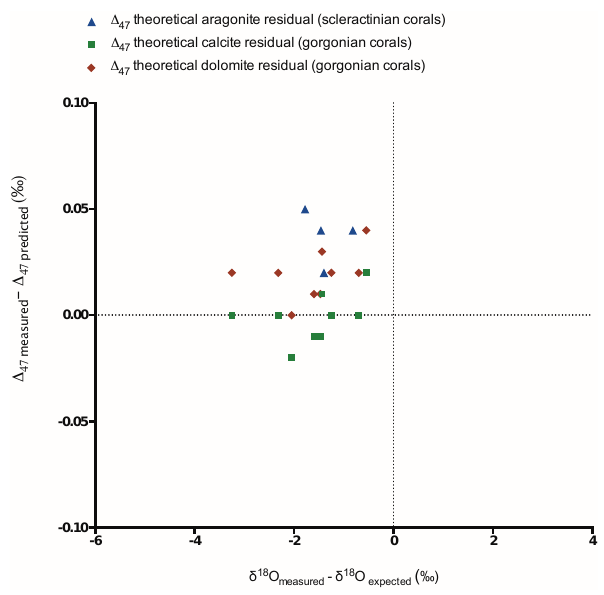
Figure 9. (cid:49) 47 residuals are calculated from average measured (cid:49) 47 values for each coral relative to the theoretical calibration of Schauble et al. (2006) paired with theoretical acid digestion frac- tionations from Guo et al. (2009). δ 18 O residuals are calculated from average measured δ 18 O values relative to the calibrations of Kim and O’Neil (1997) and Kim et al. (2007) for calcite and arago- nite,